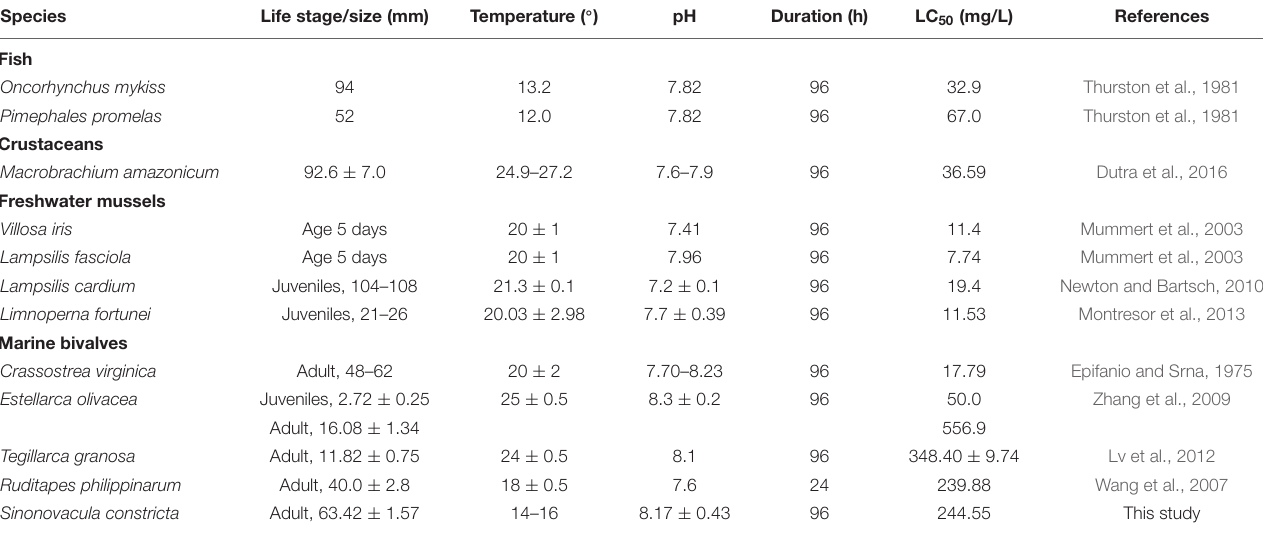
TABLE 6 | Range of the median lethal concentration LC 50 values of TAN among aquatic animals.